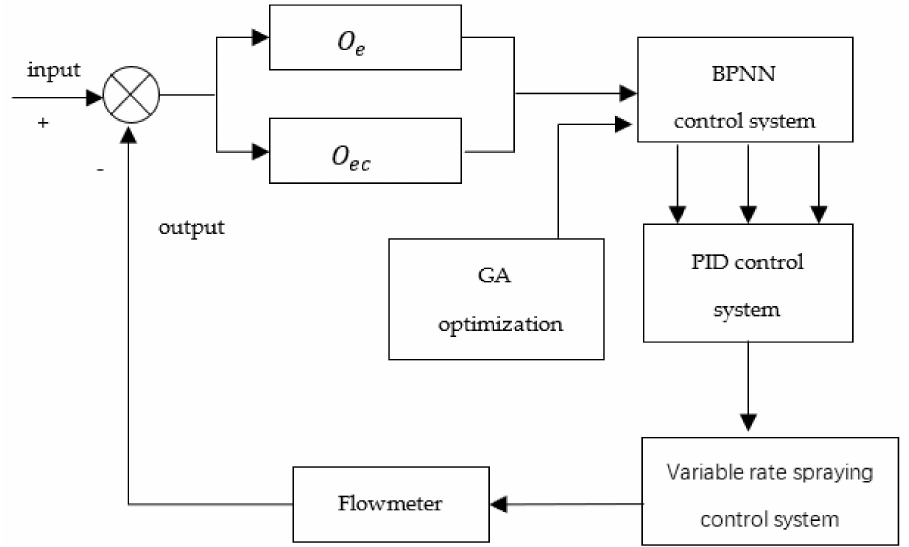
Figure 9. GA–BPNN–PID control schematic diagram.